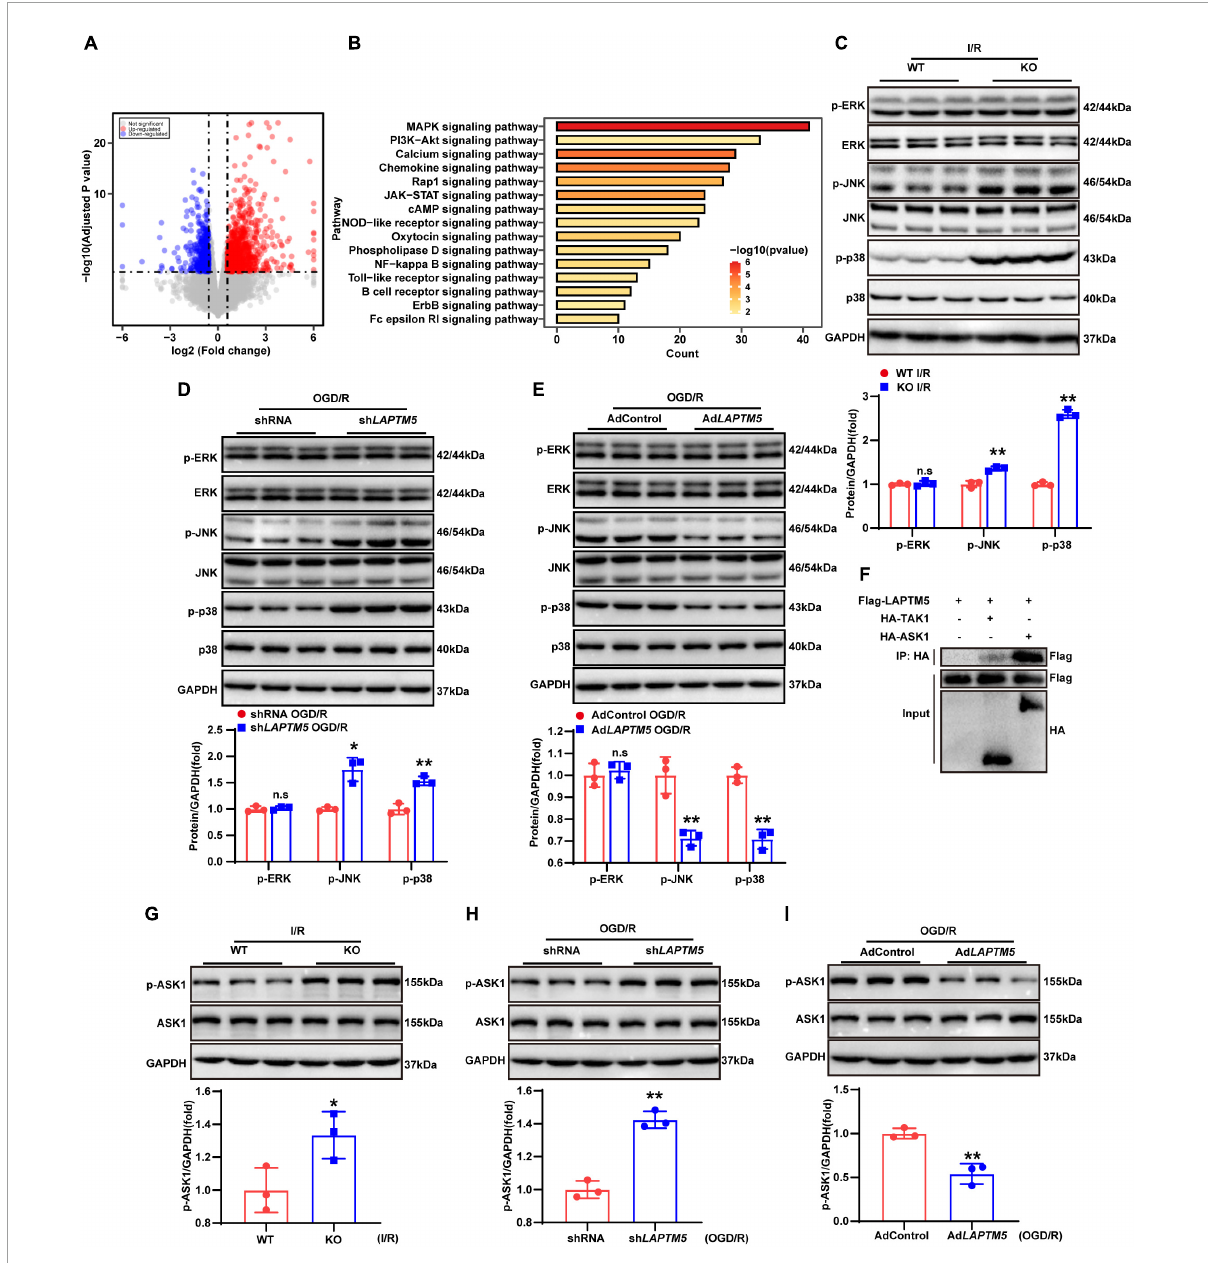
FIGURE7 LAPTM5 suppresses the ASK1-JNK/p38 signaling pathway during cerebral I/R injury both in vivo and in vitro . (A) Volcano plots showing differentially expressed genes (DEGs) in WT and LAPTM5-KO mice brains, n = 3 mice per group. (B) The top 15 most significantly enriched pathways between WT and LAPTM5-KO groups are shown based on the Kyoto Encyclopedia of Genes and Genomes (KEGG) enrichment analysis of DEGs, n = 3 mice per group. (C) Western blot showed increased protein levels of phosphorylated c-Jun N-terminal kinase (JNK) and p38, while there was no difference in phosphorylated extracellular signal-regulated kinase (p-ERK) expression in LAPTM5-KO mice after I/R. n = 3 mice per group, ** p < 0.01 vs. the WT I/R group, n.s. indicates no significance vs. the WT I/R group. (D) Western blot showed increased protein levels of phosphorylated JNK and p38, while there was no difference in p-ERK expression in the sh LAPTM5 group after OGD/R, n = 3 independent experiments, * p < 0.05, ** p < 0.01 vs. the shRNA OGD/R group, n.s. indicates no significance vs. the shRNA OGD/R group. (E) Western blot showed decreased protein levels of phosphorylated JNK and p38, while there was no difference in p-ERK expression in the Ad LAPTM5 after OGD/R. n = 3 independent experiments, ** p < 0.01 vs. AdControl OGD/R group, n.s. indicates no significance vs. AdControl OGD/R group. (F) Co-immunoprecipitation (co-IP) assays demonstrated that LAPTM5 could bind to ASK1, while it almost could not bind to TAK1 in 293T cells transfected with the indicated plasmids, n = 3 independent experiments. (G) Western blot showed increased protein levels of phosphorylated ASK1 (p-ASK1), while there was no difference in total ASK1 expression in LAPTM5-KO mice after I/R. n = 3 mice per group, * p < 0.05 vs. WT I/R group. (H) Western blot showed increased expression of p-ASK1, while no difference was observed in total ASK1 expression in the sh LAPTM5 group after OGD/R, n = 3 independent experiments, ** p < 0.01 vs. the shRNA OGD/R group. (I) Western blot showed decreased expression of p-ASK1, while no difference in total ASK1 expression was observed in the Ad LAPTM5 after OGD/R. n = 3 independent experiments, ** p < 0.01 vs. AdControl OGD/R